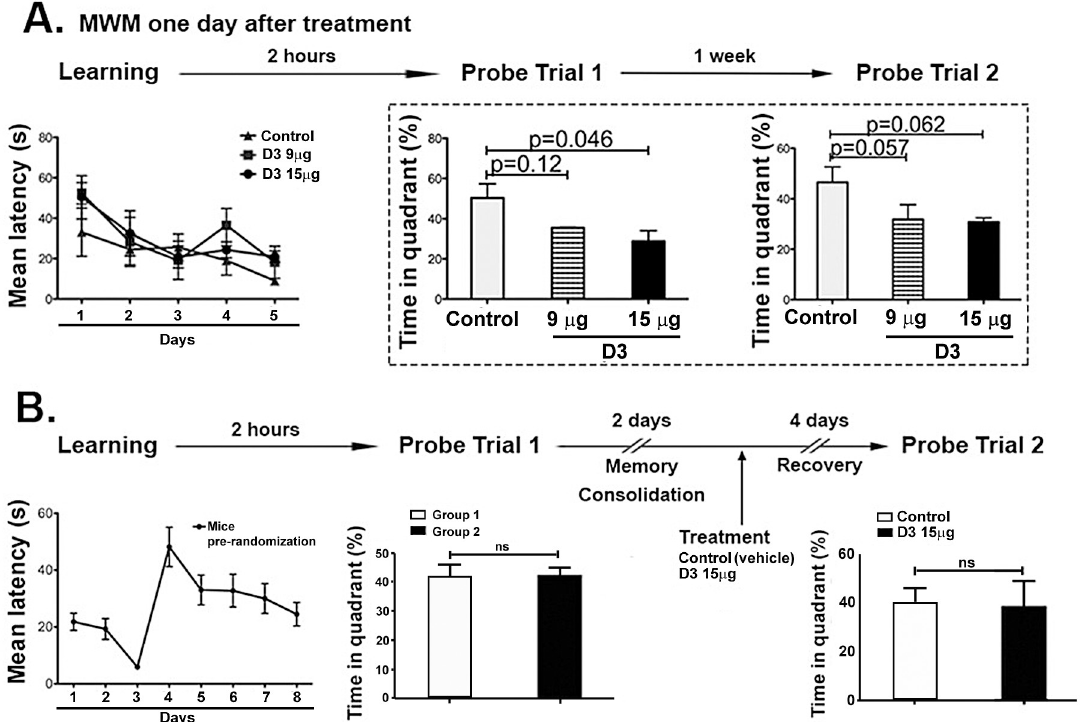
Fig 6. Acute D3 treatment conveys STM impairment that mainly affects hippocampal-dependent spatial memory consolidation. (A) Mice were trained in the Morris Water Maze (MWM) with three trials per day for 5 consecutive days. Values are shown as mean latency to find the platform (seconds). In the probe trials, values are displayed as the percentage of time the mice spent in the target quadrant. Probe Trial 1 (PT1) was performed two hours after the last trial on day 5 and Probe Trial 2 one week after PT1. Controls (n = 5), D3 9 μ g (n = 3) and D3 15 μ g (n = 5). Significant decreases in the percentage of time the mice spent in the target quadrant are framed in the dotted-line box. This experiment was performed twice independently, obtaining equal results. (B) Mice were trained as previously described and underwent PT1. They were not manipulated for the following 2 days to allow for memory consolidation. Next, they were randomly assigned to one of two groups: mice treated with vehicle (n = 6) or those treated with 15 μ g of D3 (n = 5). Four days later, controls and D3-treated mice were re-tested (PT2) to assess retrieval, and no significant difference was observed, suggesting that D3 treatment impairs memory